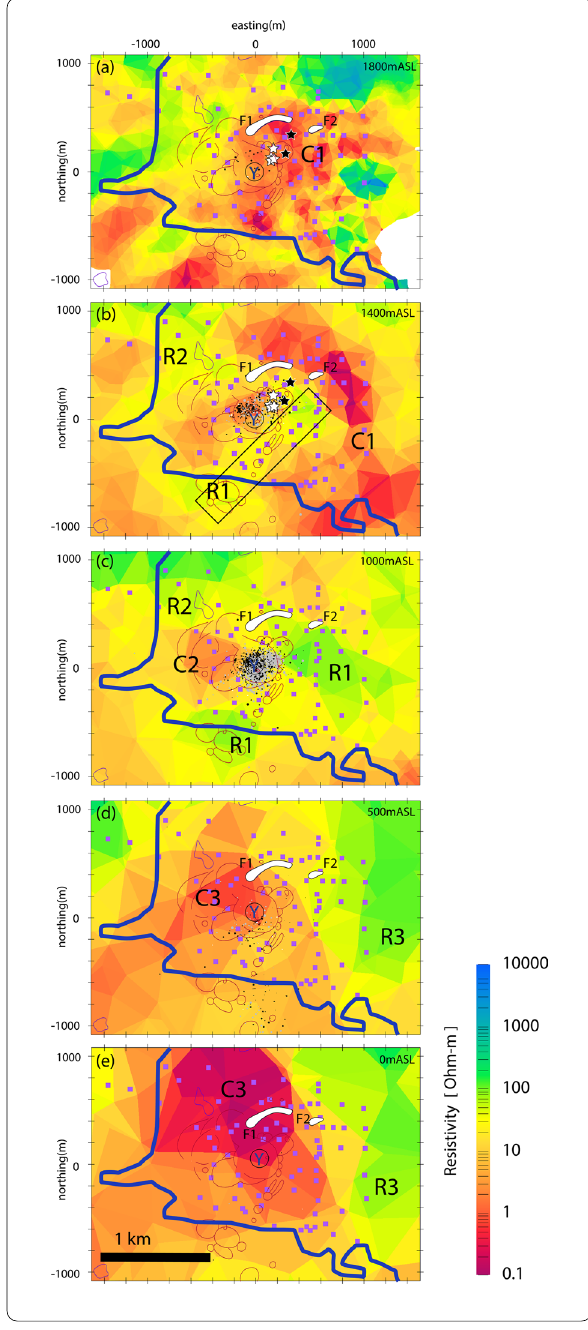
Fig. 3 Depth slices at a 1800 m ASL, b 1400 m ASL, c 1000 m ASL, d 500 m ASL and e 0 m ASL from the 3-D resistivity inversion at the peak area of Kusatsu–Shirane volcano. Seismic hypocenters are mapped as dots on each map within 200 m tolerance in depth. The white, black, and gray dots denote hypocenters for three periods before, during and after the 2014 unrest, namely from August 2013 to February 2014, from March 2014 to May 2014, and from June 2014 to February 2019. The white and black starts denote horizontal locations of magnetizations and demagnetizations corresponding to volcanic events from 1978 to 2012 after Takahashi & Fujii (2014). The red circles and open curves show the crater rims of past eruptions. The rectangle in (b) denotes the fitting between the resistor R1 and the locations of historical eruptions. Major fumaroles (F1 and F2) are shown by white closed